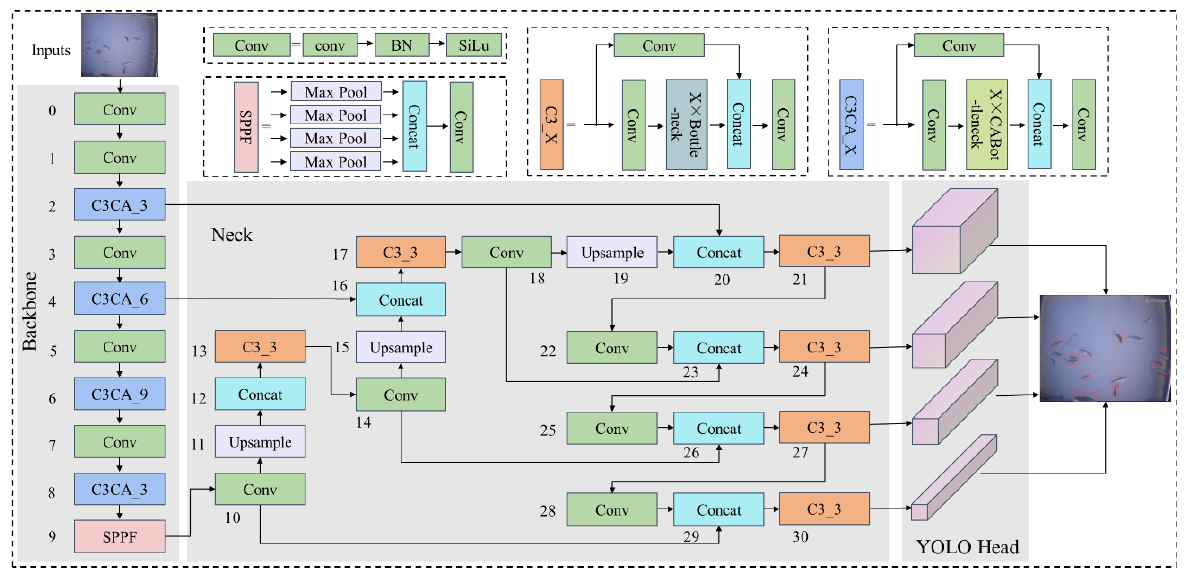
Figure 1. This is a figure that showing CME-YOLOv5 network structure. The numbers 1 to 30 in the figure represent the layers of the CME-YOLOV5 model.